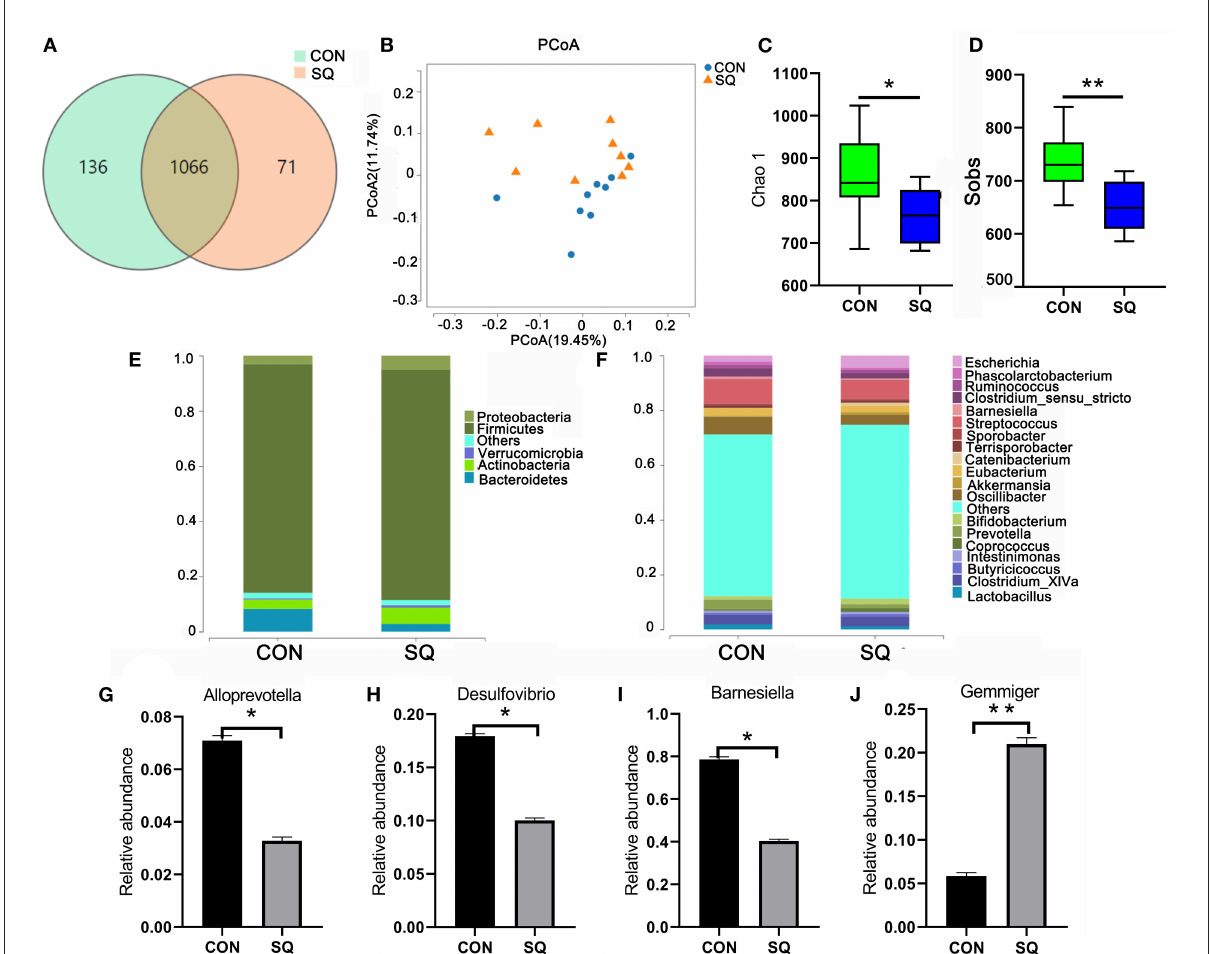
FIGURE6 SQ improved gut microbiota of weaned piglets. (A) The Wayne figures of fecal microbiota. (B) PCoA analysis of fecal microbiota at the OUT level. (C) The Chao 1 index of fecal microbiota. (D) The Sobs index of fecal microbiota. (E) Relative abundance of fecal microbiota at the